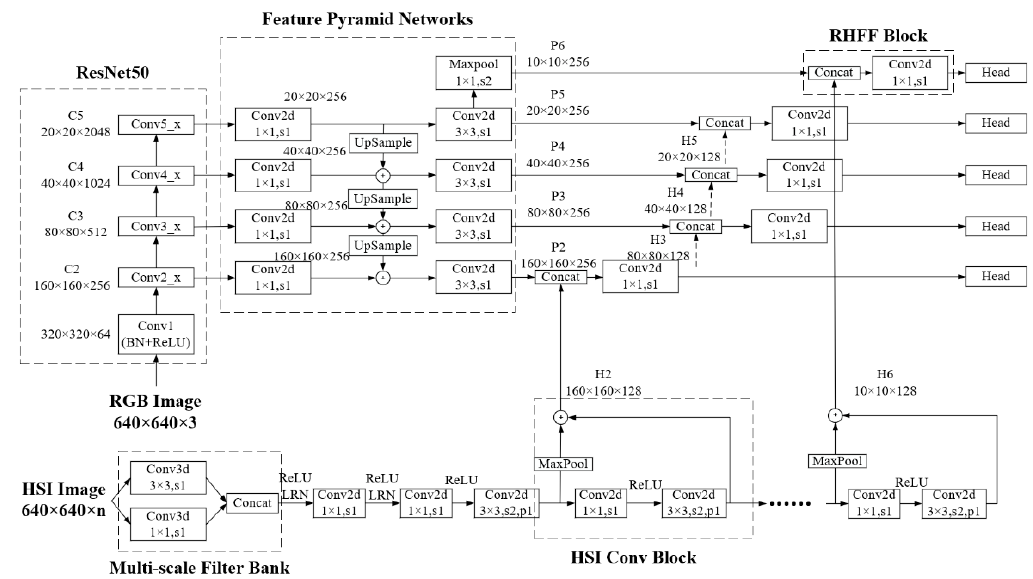
Figure 2. Network structure of RHFF-SOLOv1.